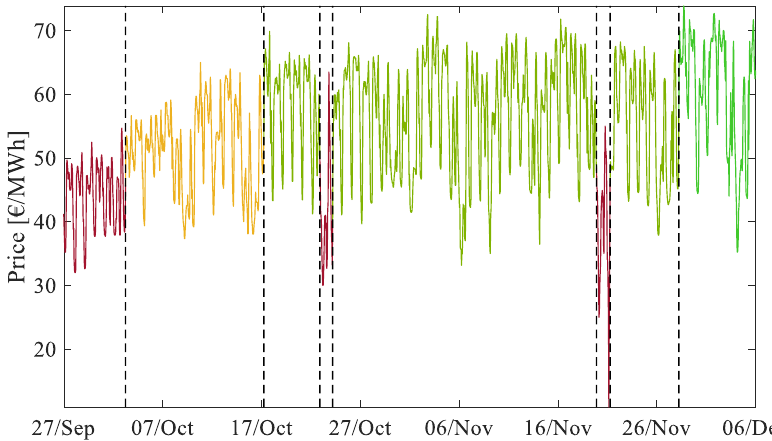
Figure 2. Iberian electricity market prices during autumn 2016.